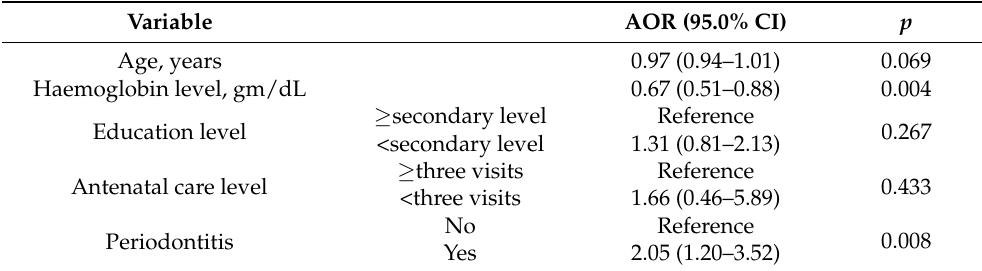
Table 3. Multivariate analysis of the adjusted factors associated with preterm birth at Omdurman hospital in Sudan,